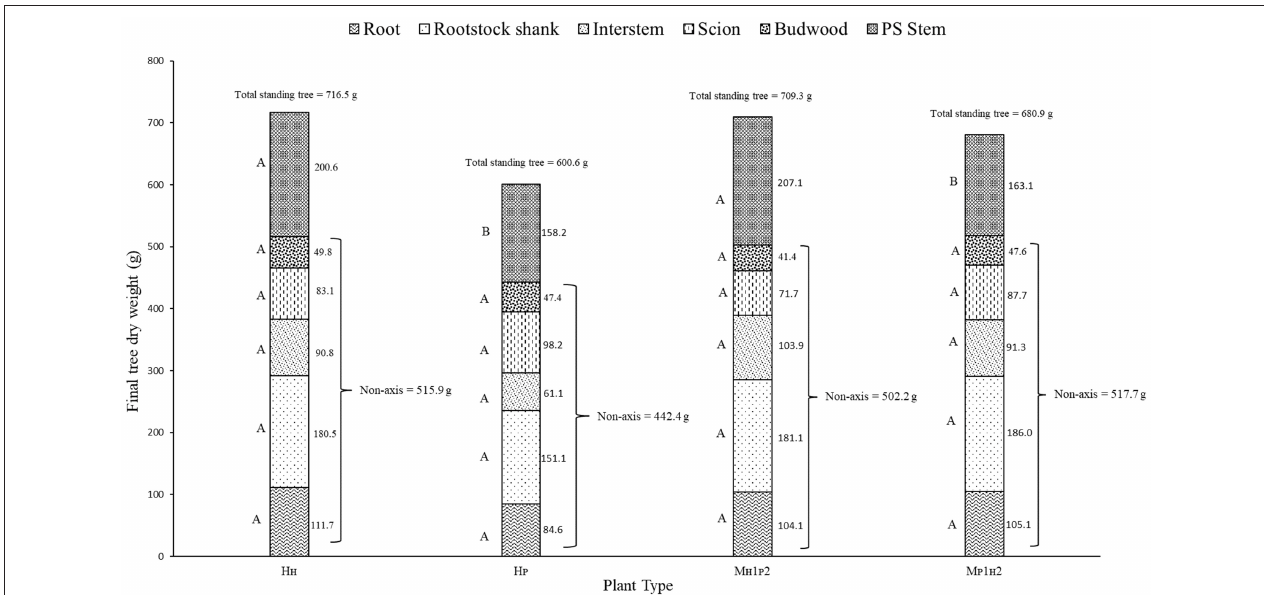
FIGURE 7 | Total standing tree dry weight of ‘PremP009’ and ‘Hosui’ homogenous (H P and H H ) and the two combinations of M plant type (M H1P2 and M P1H2 ). Letters on the left side of the histograms indicate the mean separation between each part of the plant. P < 0.05.